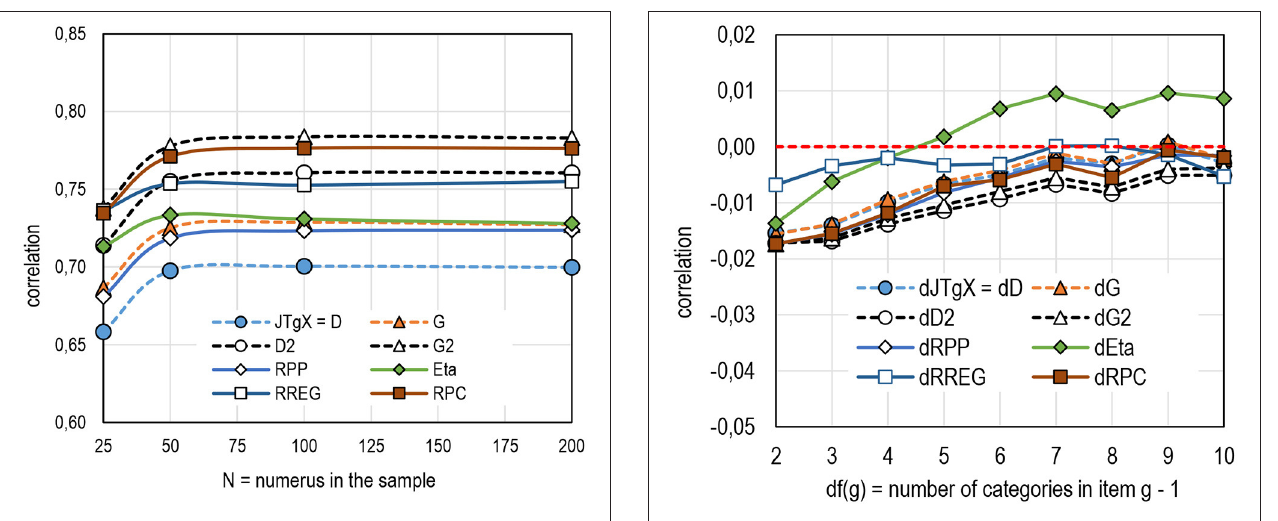
FIGURE 7 | Average difference between the sample and population by df(g) (k = 6,932